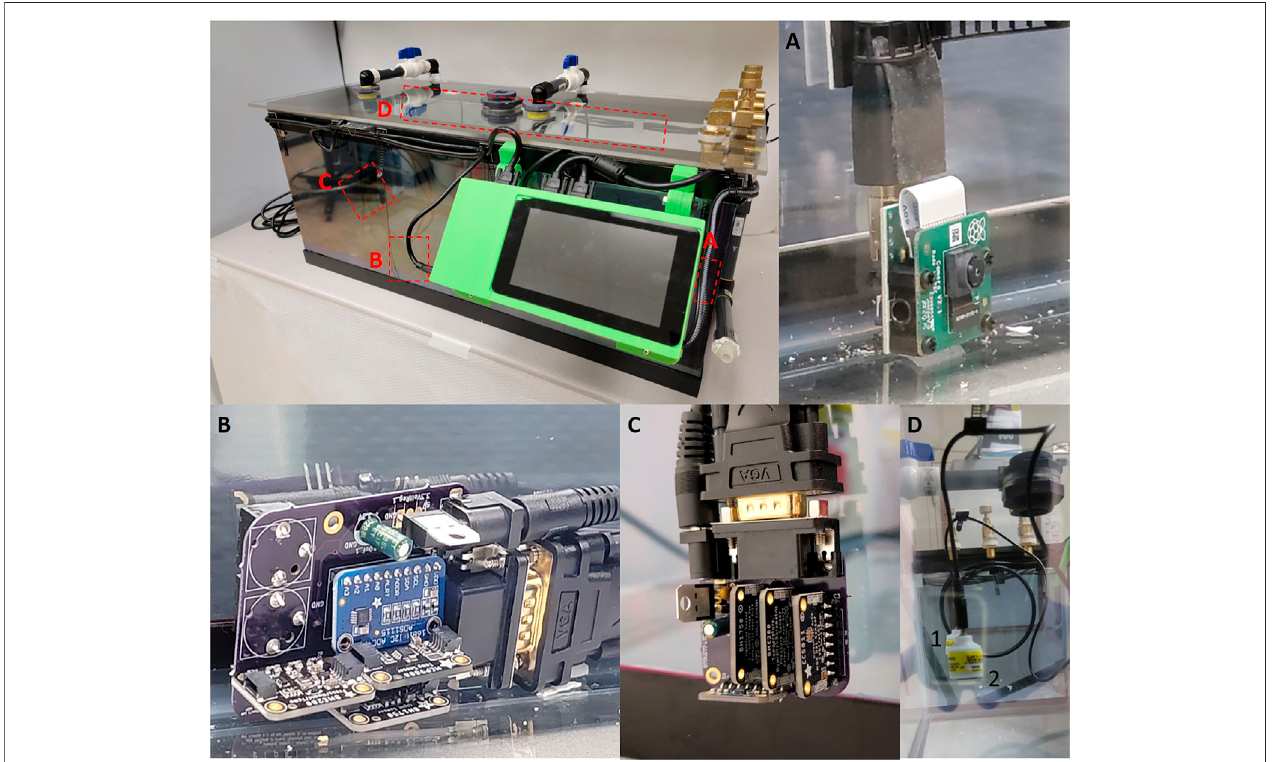
FIGURE 1 | (A) Raspberry Pi Camera version two attached to the Raspberry Pi via a HDMI cable. (B) Central sensor PCB board with ADS1115, MCP9808, BME280 and BH1750 sensors, the rear of the board contains two Aux jacks which allow for Teledyne sensor attachment. (C) External sensor breakout which contains MCP9808,BME280,BH1750andCCS811. (D) Teledyneoxygensensorshungfromtheroofofthechamber utilizingcablemanagementclips.Twosensorsareheldby cables clips on the sealing, identi fi ed by the one and two identi fi